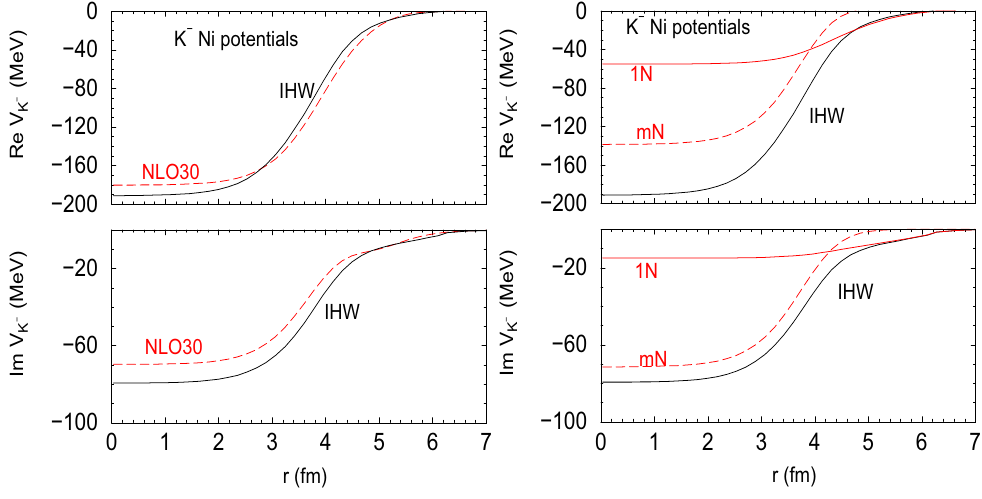
Figure 4. Left: Self-consistent K − nuclear potentials V K − for K − atoms of Ni derived from global fits based on in-medium IHW amplitudes [16], with the corresponding 1N and many-nucleon (mN) components on the right panel. The dashed curves in the left panel are derived from in-medium NLO30 amplitudes